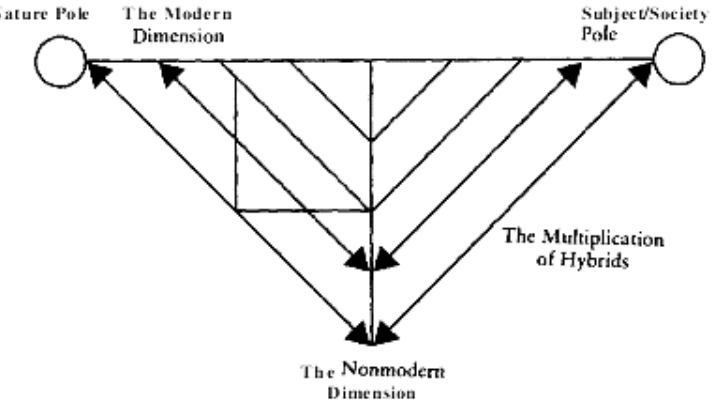
Fig. 6 Latour's intention putting society (humans) and nature on the same page to make no a priori distinction between them. All cultures are presumably in the hybrid forms (Latour, 1993, p. 51). Humans belong to nature, and the other way